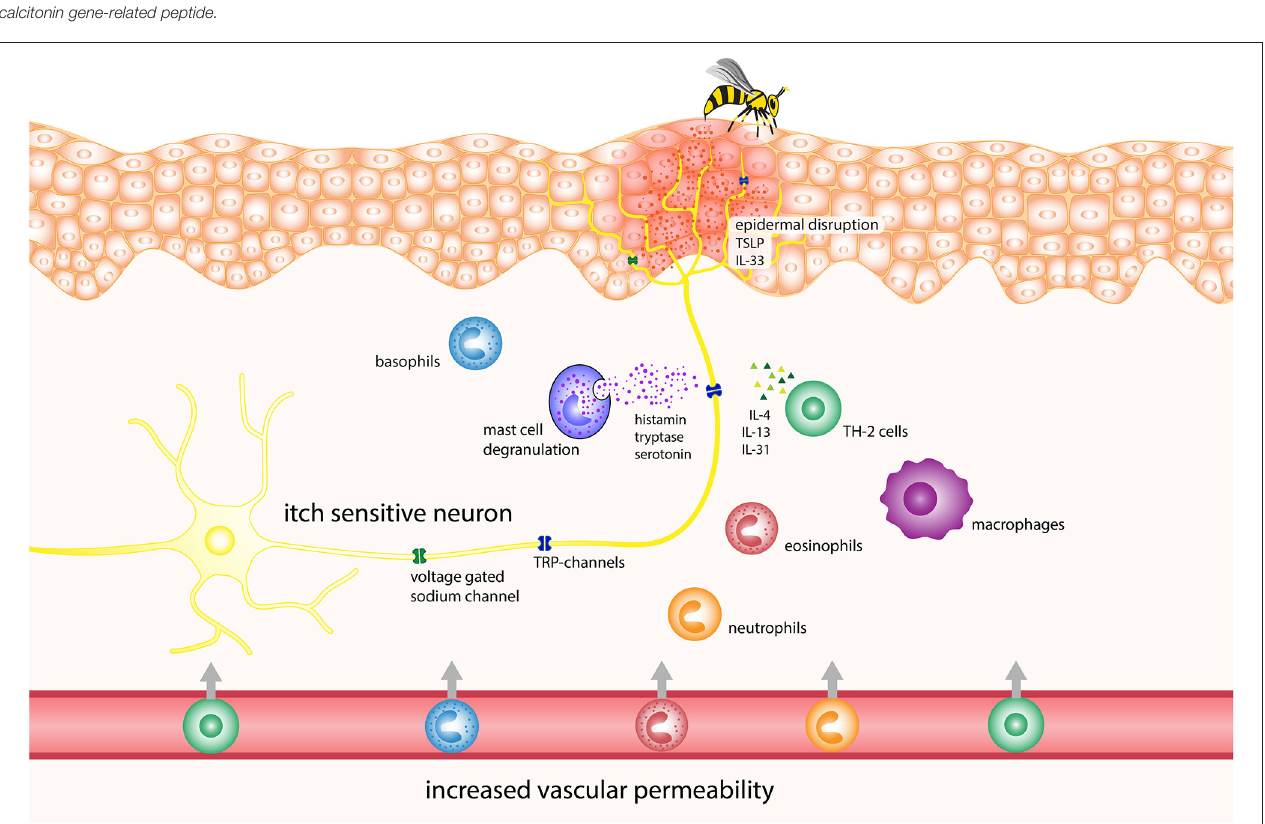
Phospholipase 1 Phospholipase 1 (PLA1) is a non-glycosylated protein which is ∼ 20–30% homologous to the human lipase (45). It causes